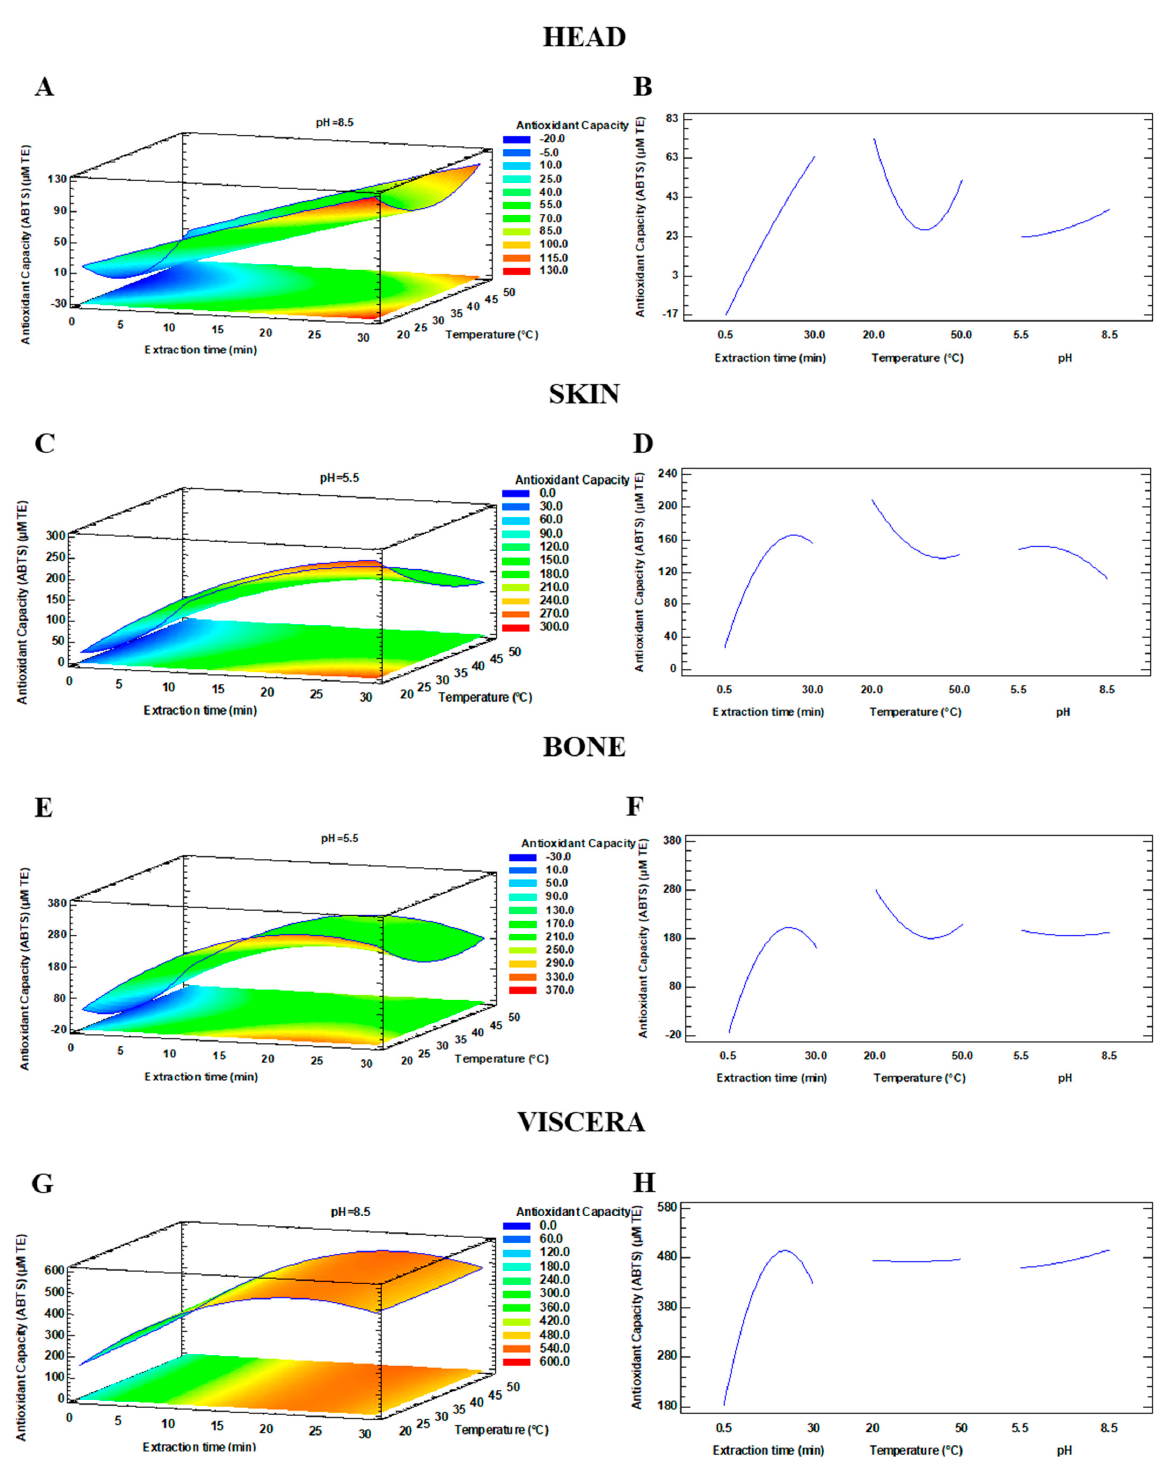
Figure 3. Plots shown in ( A , C , E , G ) indicate the response surface plot for the percentage of antioxidant capacity as a function of the extraction time (min) and temperature ( ◦ C) at a fixed pH. The plots in ( B , D , F , H ) show the influence of the different parameters (extraction time, temperature, and pH) on the antioxidant capacity determined as µ M trolox equivalent using ABTS